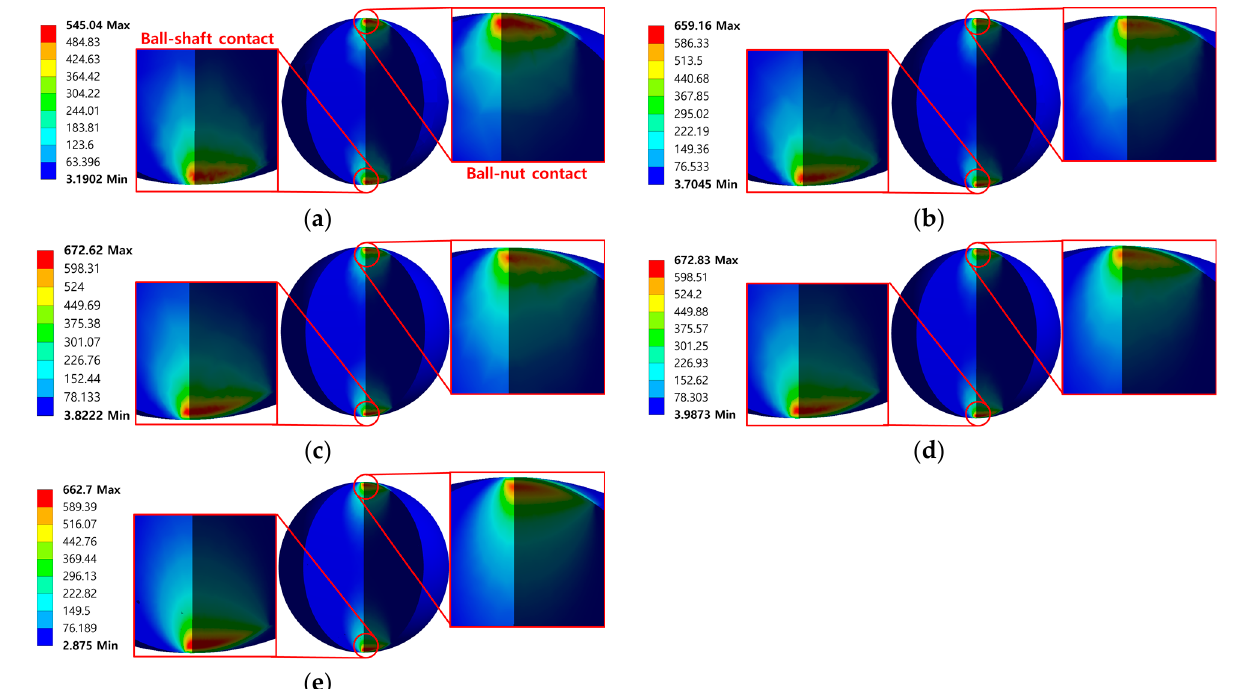
Figure 9. Equivalent stress (MPa) results of contact theory based model (ball): ( a ) Type1; ( b ) Type2;